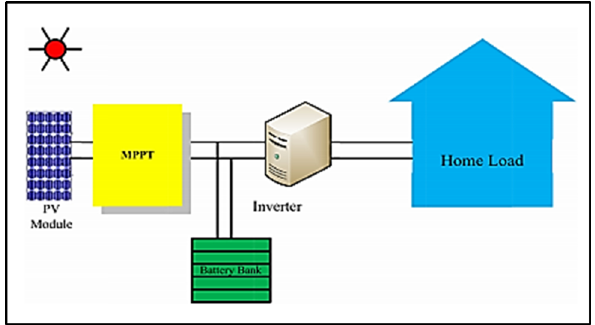
Figure 1: Stand - alone PV